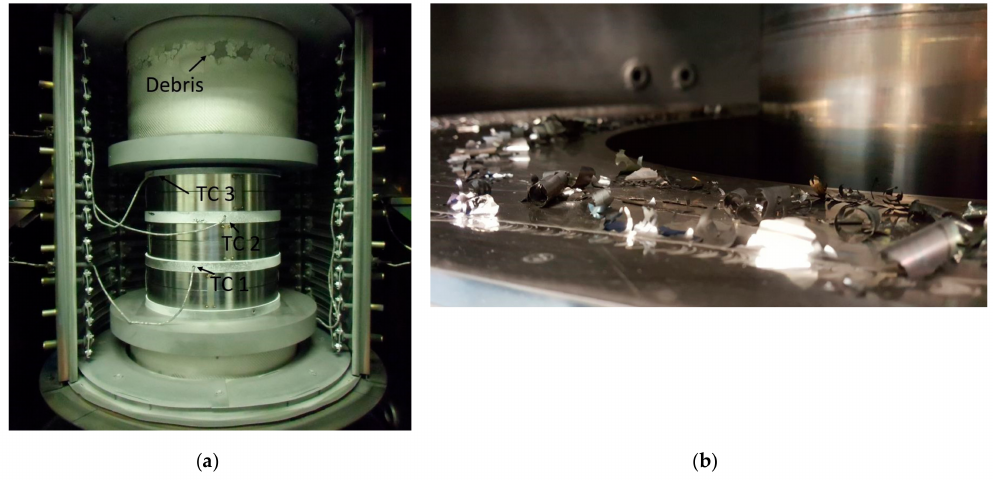
Figure 6. ( a ) Di ff usion bonding furnace with three sample thermocouples (TC) and debris. ( b ) Flaking precipitations at the cooled furnace wall.